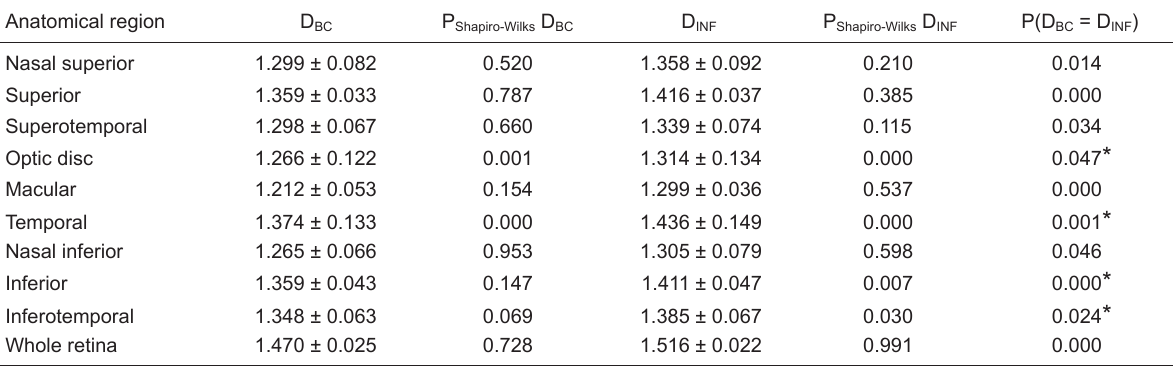
Table 1. Box-counting (D BC ) and information (D INF ) methods for determining the fractal dimensions of each anatomical retinal region and of the whole retina of 28 control individuals (without non-proliferative diabetic retinopathy). Anatomical